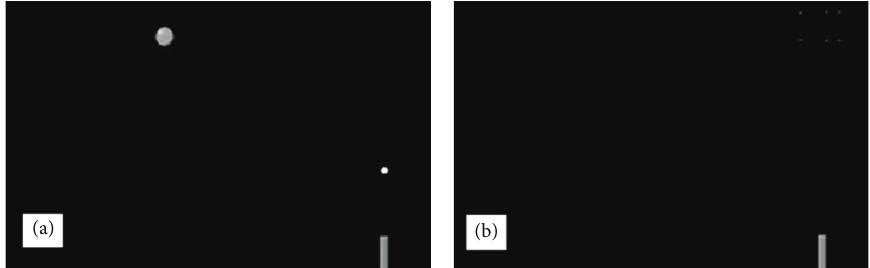
Figure 1: The experimental task. (a) The green ball flies from the left side of the screen to the upper right corner, the interception zone. The “gun” in the right lower corner has just fired a “projectile” travelling vertically at a constant speed to intercept the target. (b) Successful hit is associated with an “explosion” in the interception zone in the upper right corner. If the subject misses, no animation is displayed.